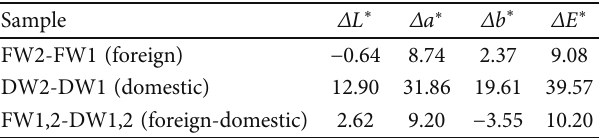
Table 5: Colour di ff erence of wine samples.